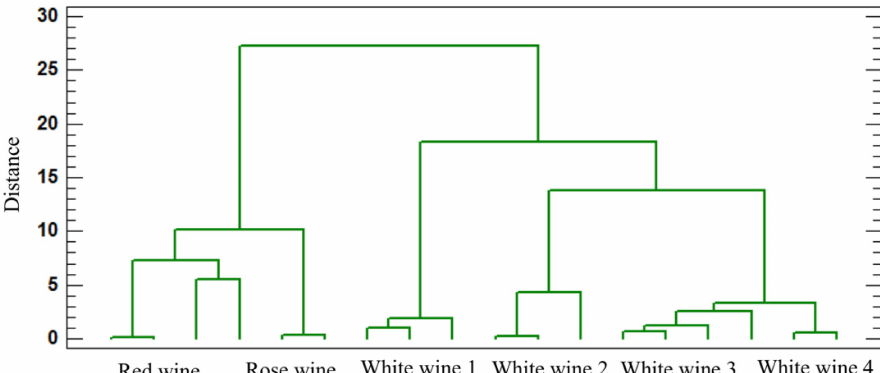
Figure 4. The cluster analysis according to Ward’s method of pesticide